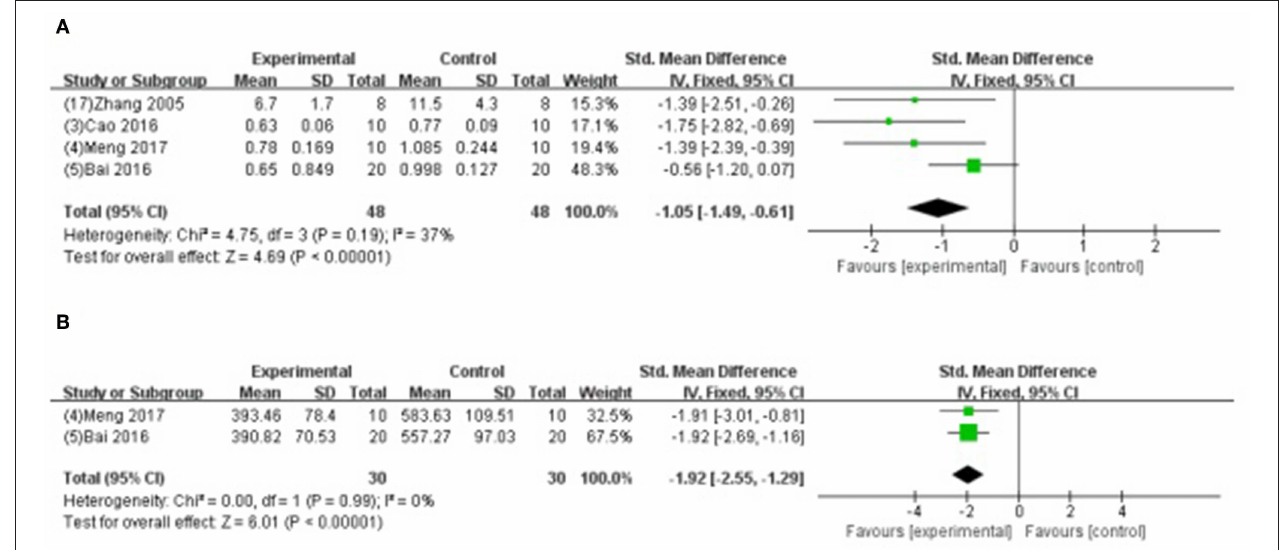
FIGURE 7 | (A) Forest plot of animal studies investigating the effect of GB on creatine kinase decrease. (B) Forest plot of animal studies investigating the effect of GB on aspartate transaminase